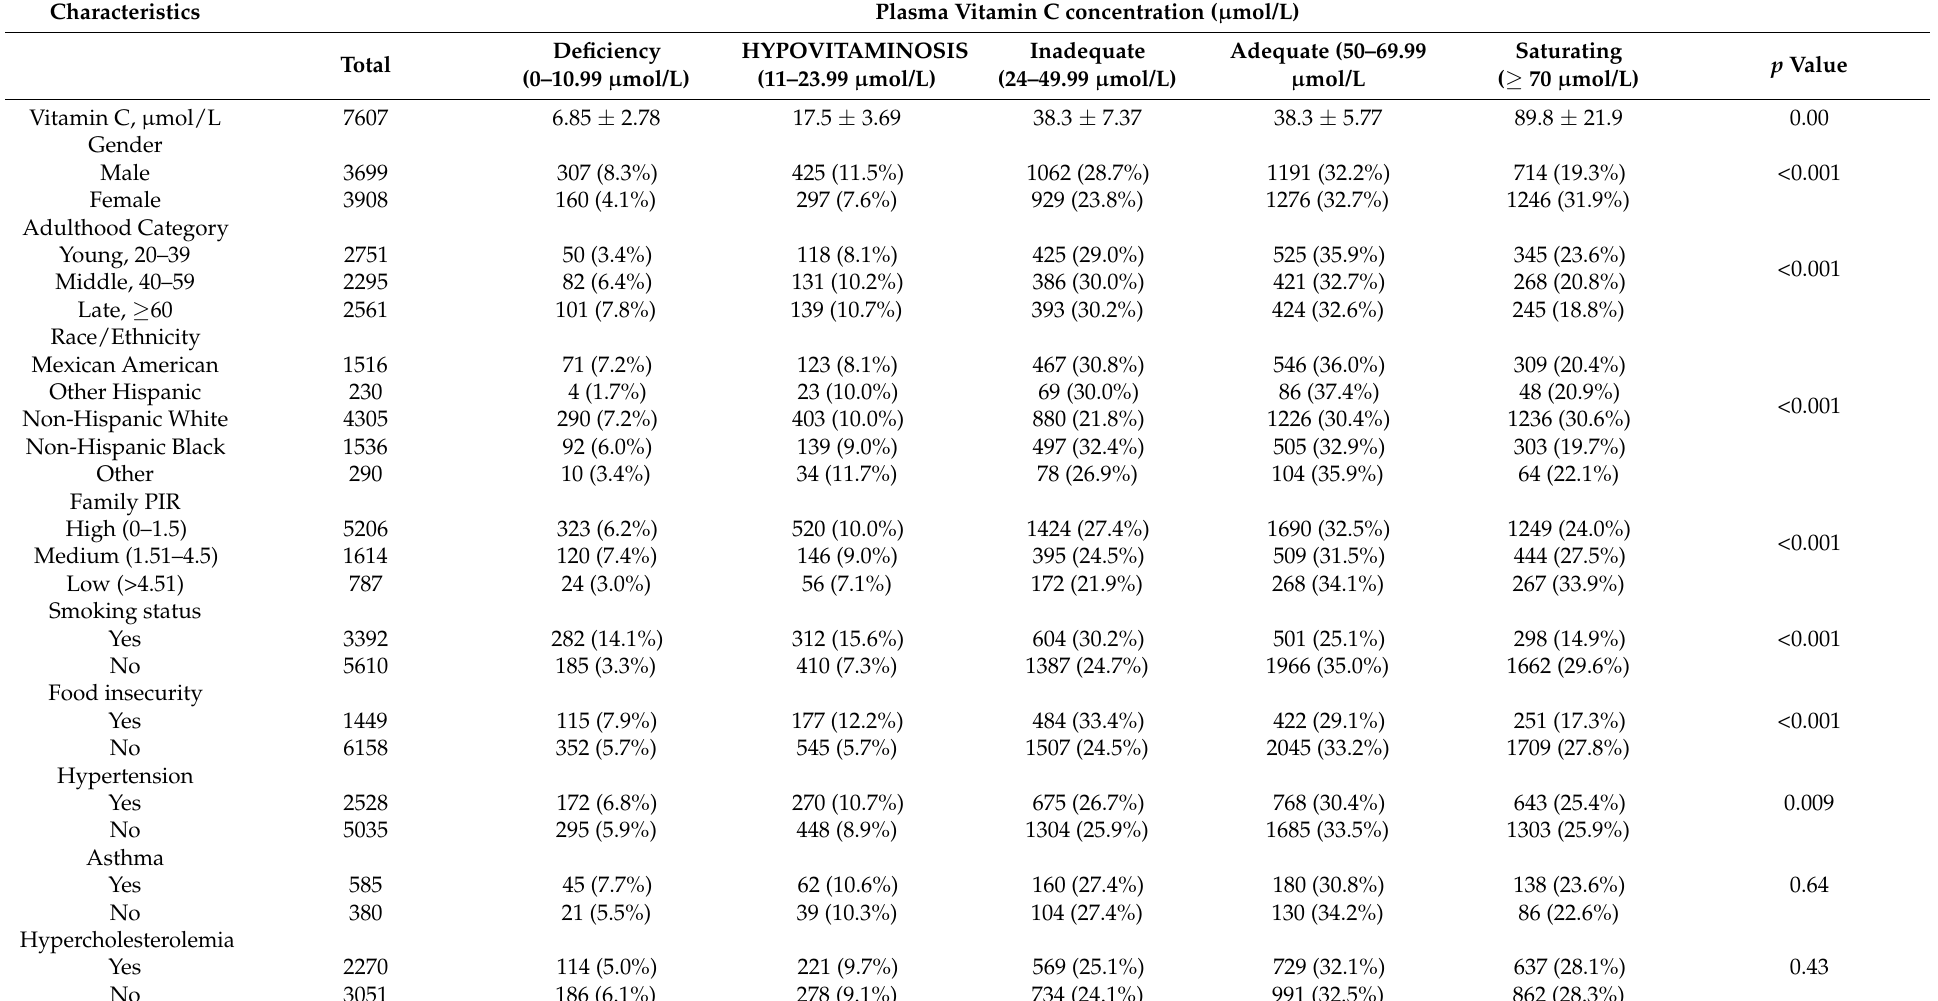
Table 2. Baseline Characteristics of Participants by Plasma Vitamin C